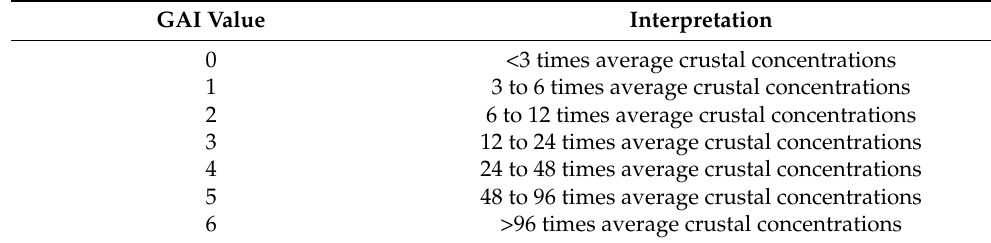
Table 3. Categories applied to GAI values [29]. GAI